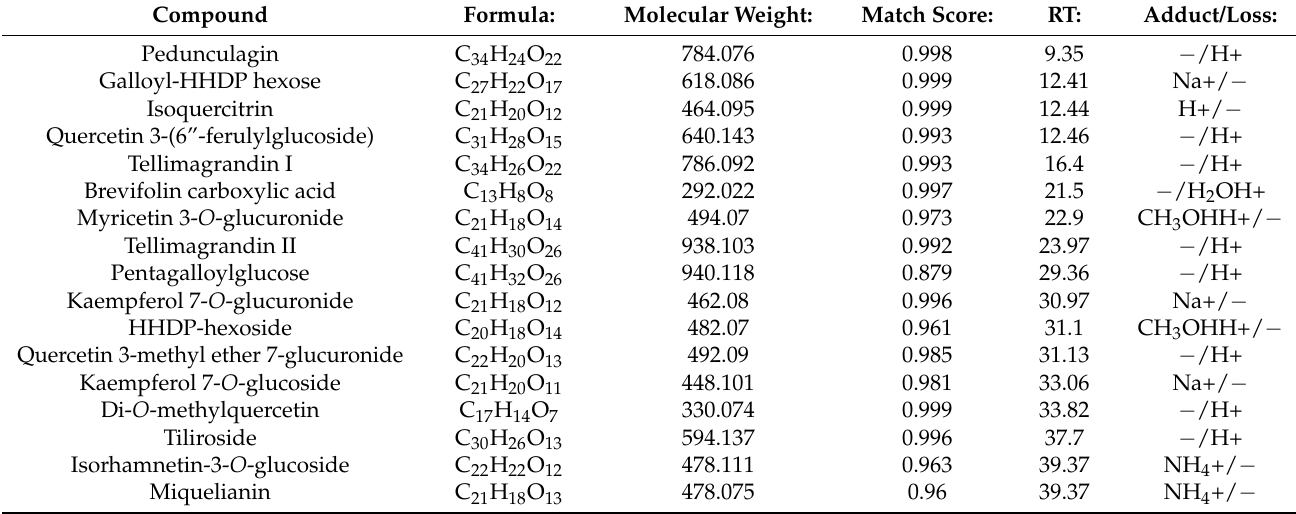
Table 1. Polyphenols identified in A. viridiflora methanol extract sample by LC-MS method. Compound Formula: Molecular Weight: Match